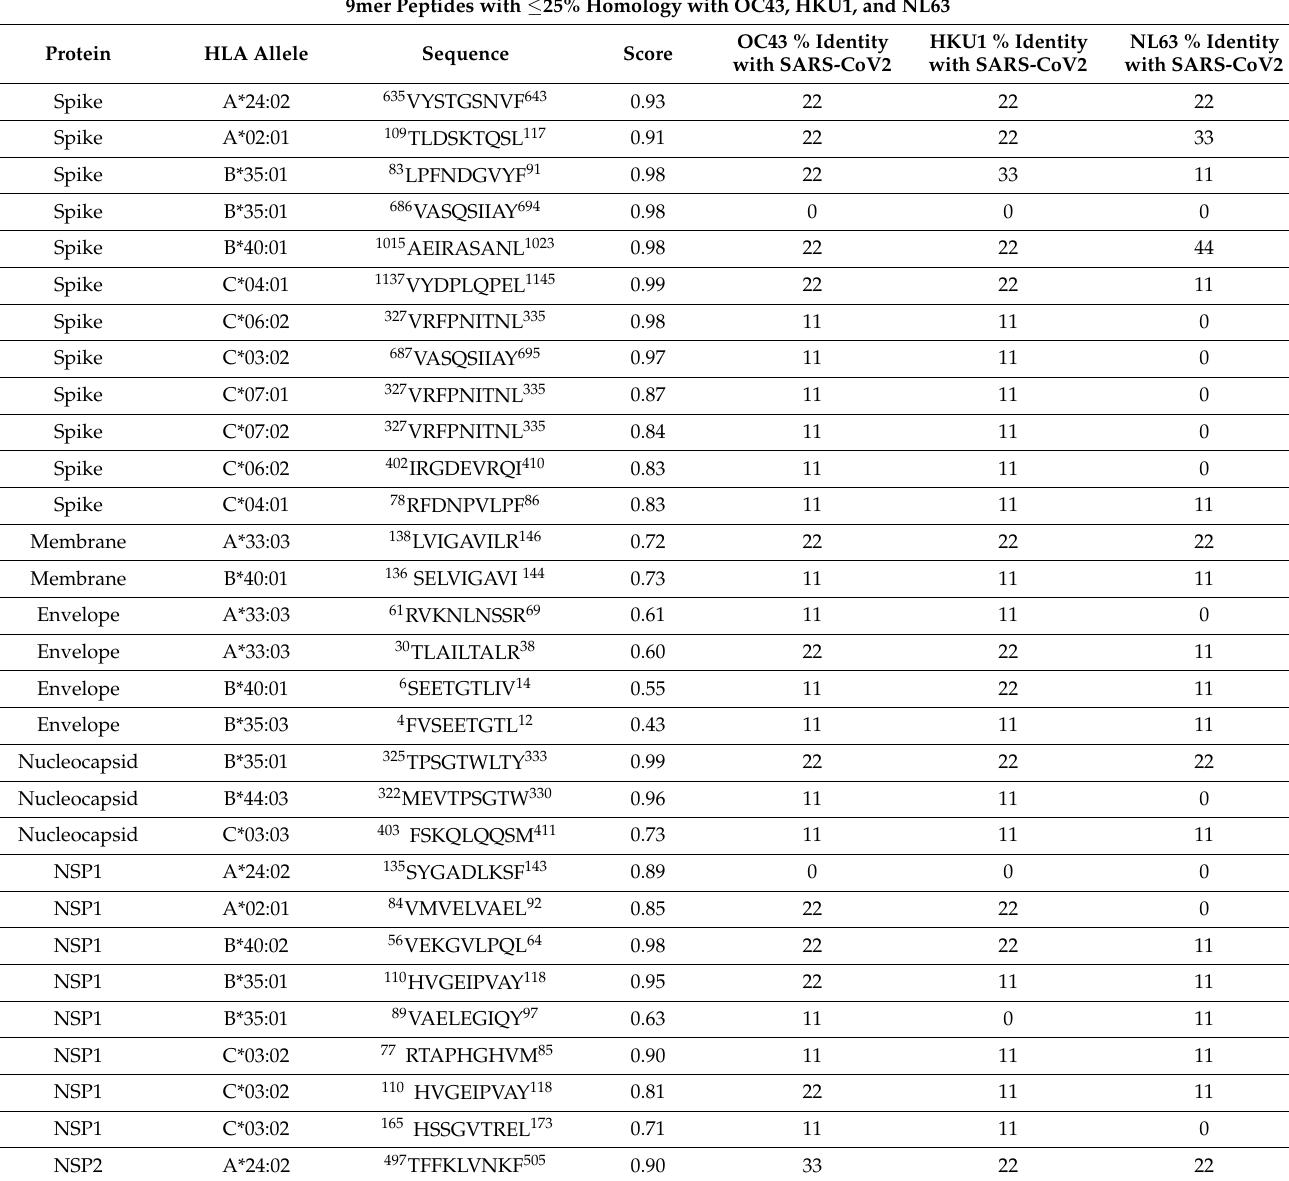
Table 5. Predicted CD8 + epitopes of the SARS-CoV2 virus, which show ≤ 25% homology with OC43, HKU1, and NL63. 9mer Peptides with ≤ 25% Homology with OC43, HKU1, and